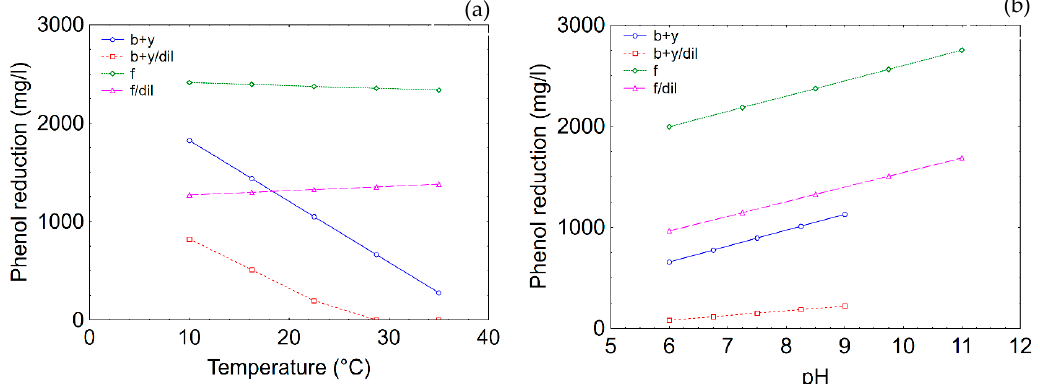
Figure 8. Prediction profiles for the effects of temperature ( a ) and pH ( b ) on COD reduction. b + y, combination Bacillus/Candida ; f, fungus ( T. harzianum ); dil, diluted TOPW.